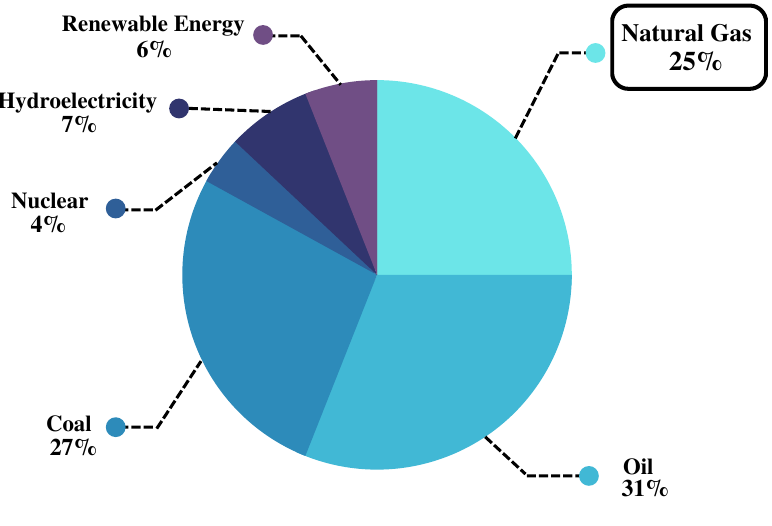
Figure 1. Global primary energy consumption in